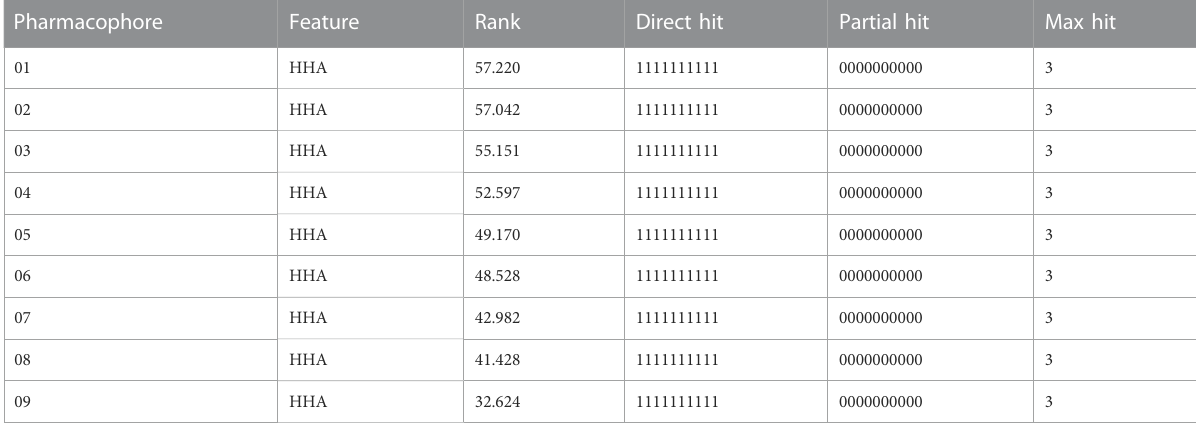
TABLE 3 Common characteristic parameters of active compounds displayed by pharmacophore models. Pharmacophore Feature